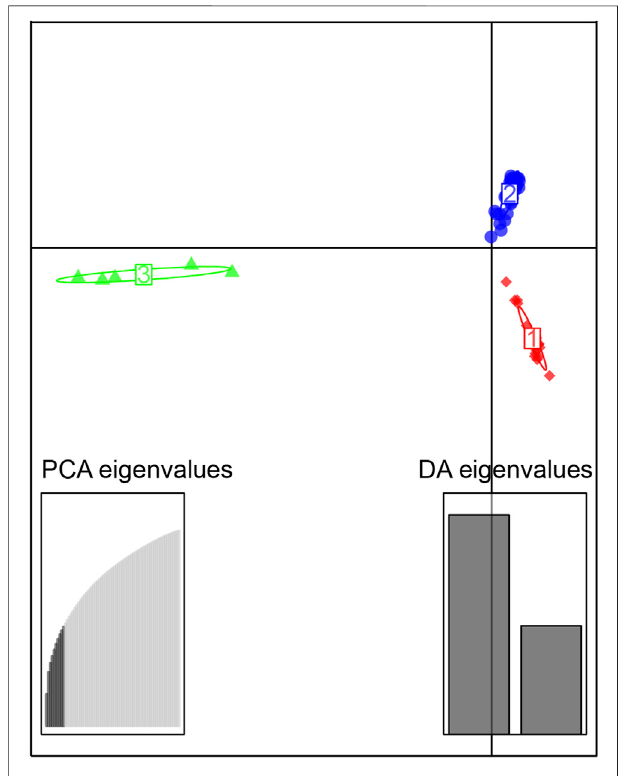
FIGURE 3 | Scatterplot generated by the discriminant analysis of principal components (DAPC). The 72 individuals were divided into 3 clusters, red, the Qiantang and lower Yangtze group (QY), blue, the middle Yangtze group (MY), and green, the Oujiang group